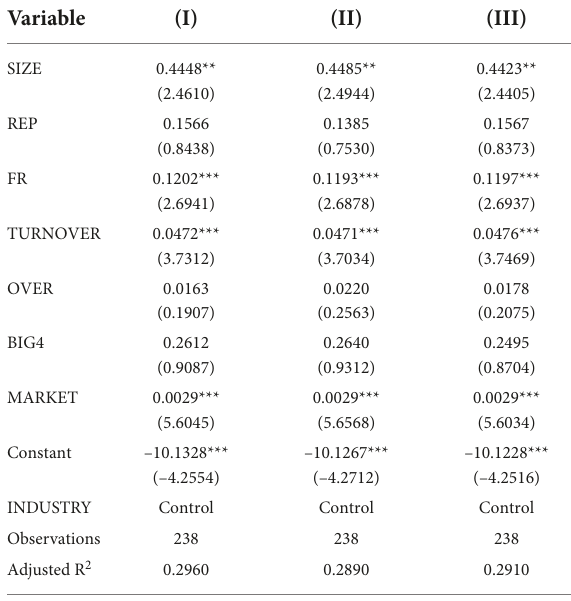
TABLE 5 Regression results of media sentiment on the first-day returns of COVID IPOs and non-COVID